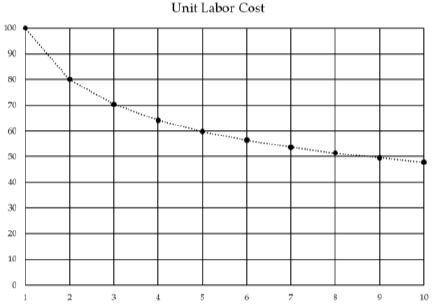
Figure 2. Unit l earning model graphic [12]. Figure 2. Cumulative average learning model graphic